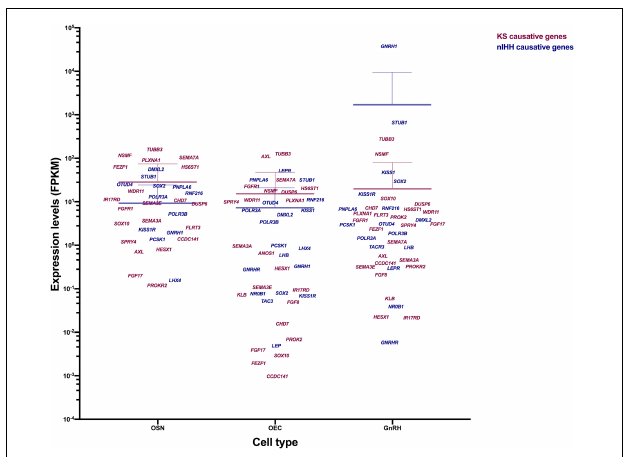
FIGURE 7 | Expression level of genes causing KS vs. nIHH in OSN, OEC, and GnRH neurons. Genes related to KS (magenta) and genes only related to nIHH (blue) are plotted according to their expression level (FPKM) in the three different cell types. The gene expression values are gathered from previous studies and GEO database and compared in OSN (GSE53793), OEC (GSE69312) and GnRH neuron (Burger et al., 2018). The mean expression level and SD of gene group is represented as same color on the scattered